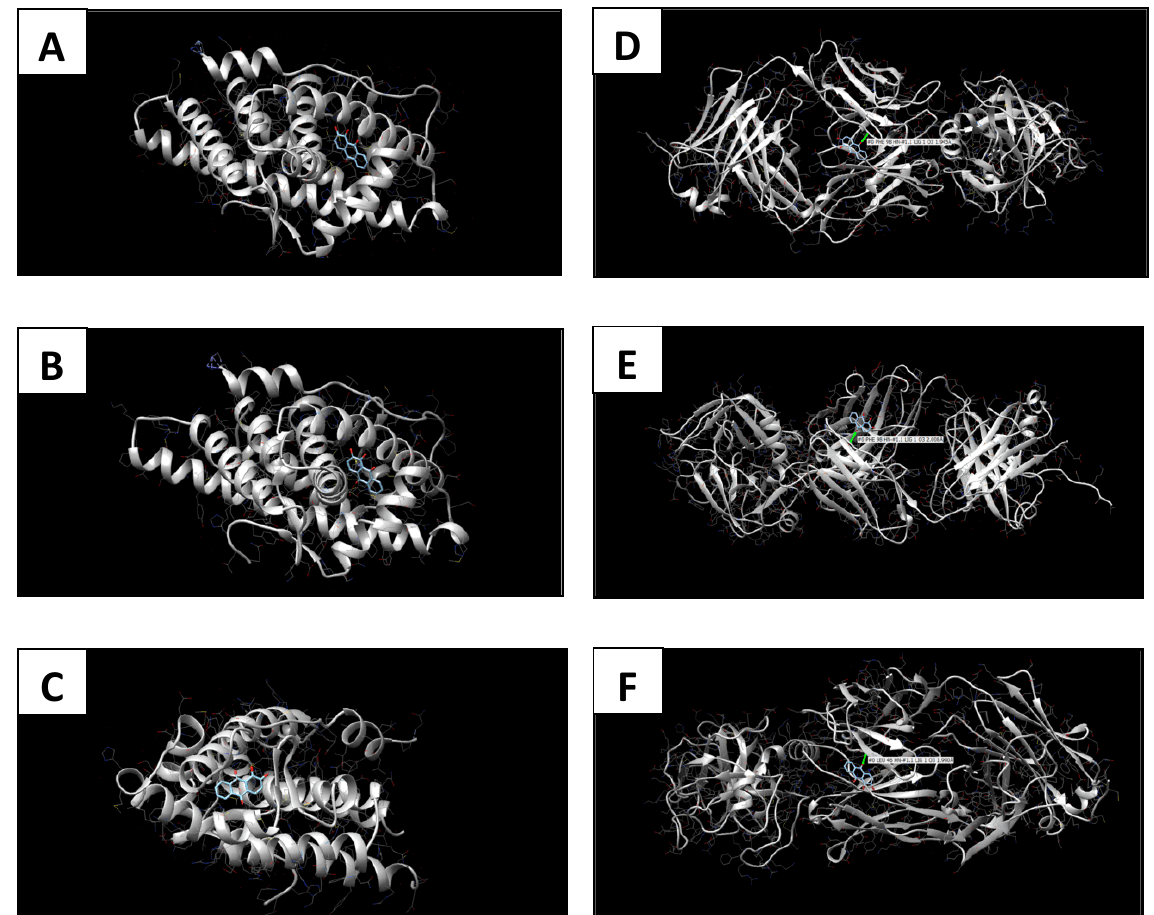
Figure 1. Molecular docking of alizarin with androgen receptor (AR) PDB codes: 3RLJ (A), 5T8J (B), 5VO4 (C), and protein specific antigen (PSA) PDB codes: 2ZCH (D), 2ZCK (E), 2ZCL